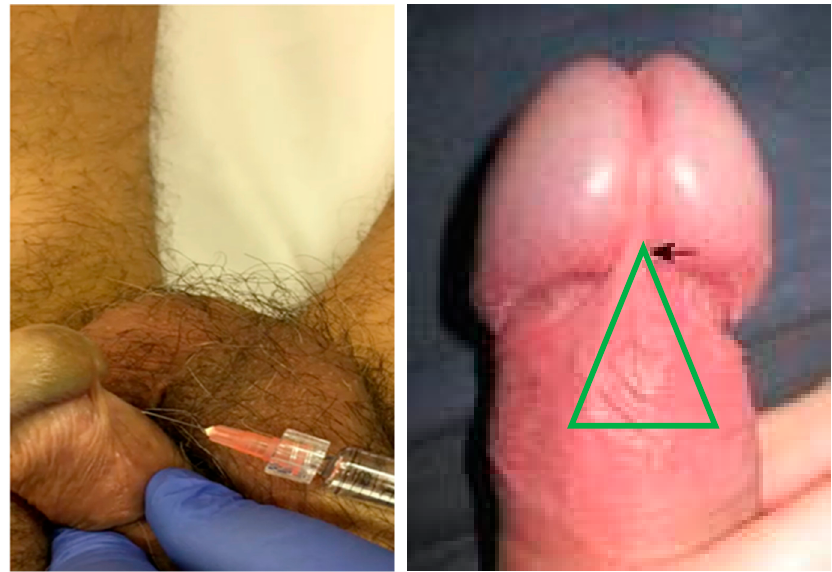
Figure 1. HA gel injection technique ( left panel ) into the MONAVER Triangle area ( right panel